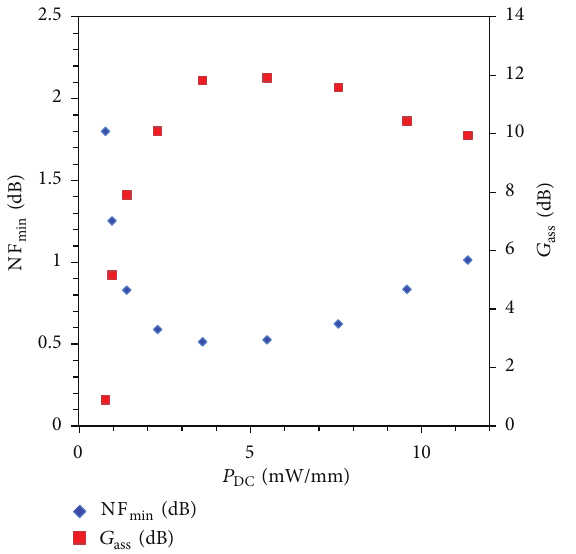
as Figure 10: Noise equivalent resistance 𝑅 𝑛 and output noise tem- ass as a function of power consumption at 12 GHz for perature 𝑇 out = 80 𝑉 𝑑𝑠